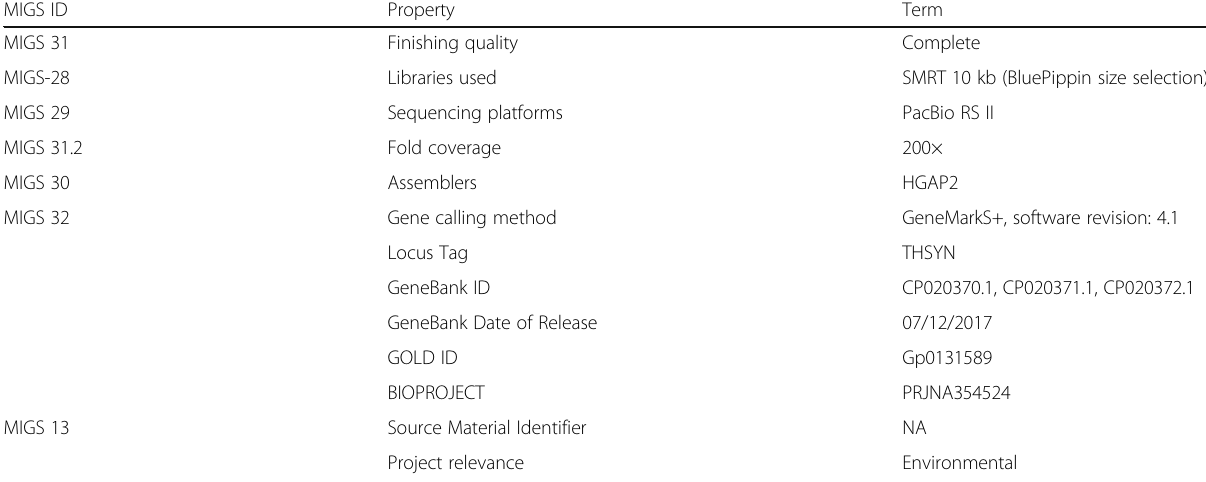
Table 2 Project information for “ T. syntrophicum ” sp. nov. strain Cad16 T